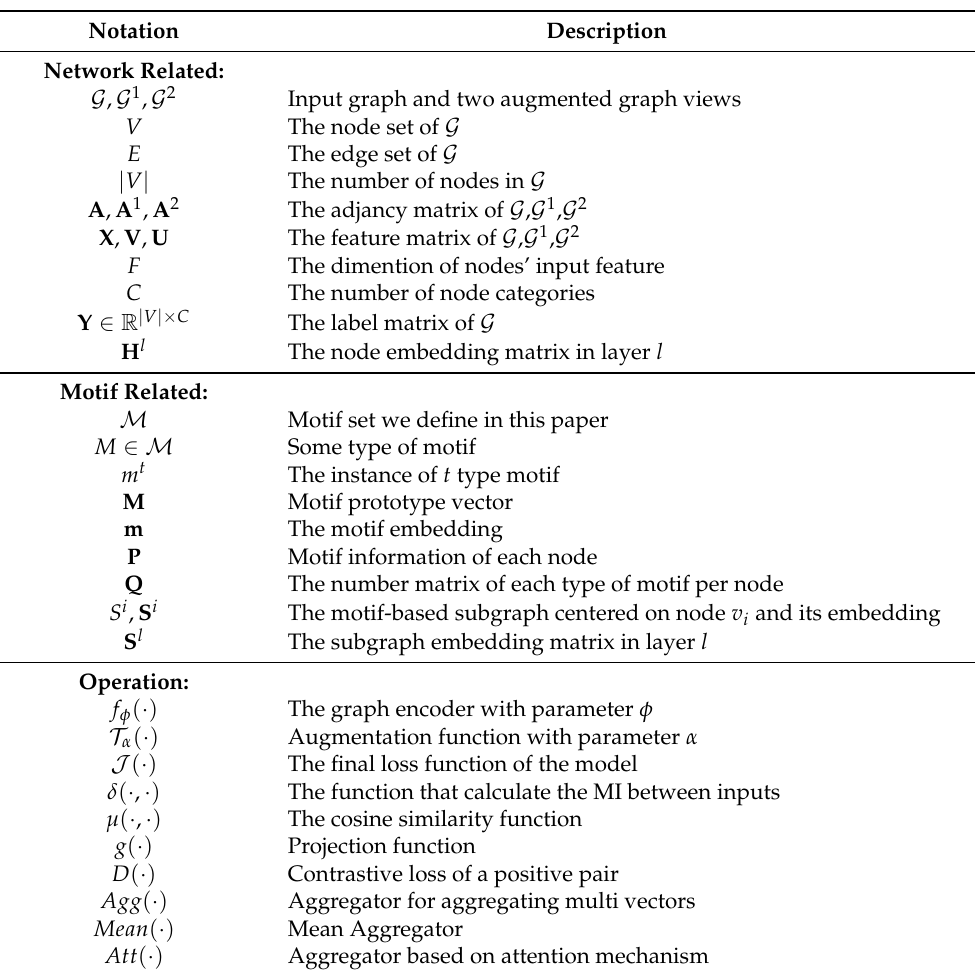
Table 1. Notations used in this